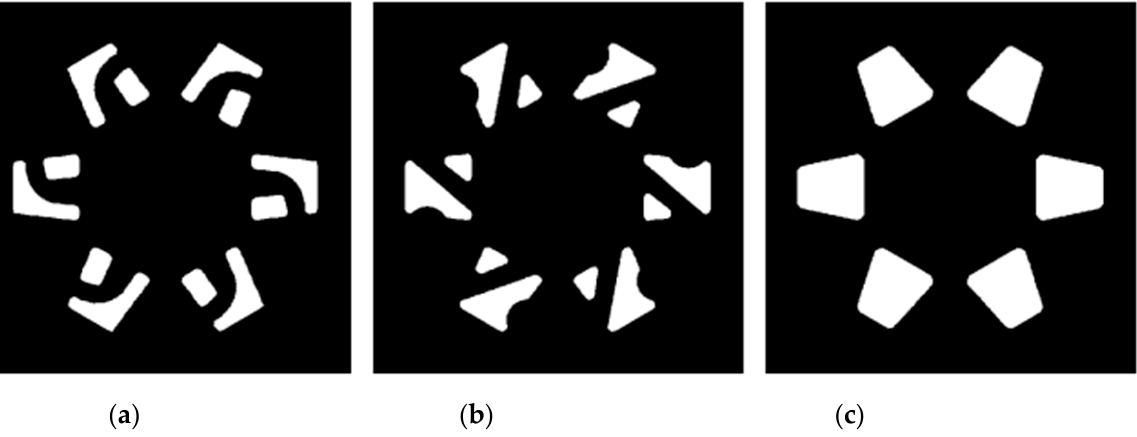
Figure 5. Simulated tool heads used in this work, containing six abrasive elements of: ( a ) 320 grit; ( b ) 400 grit; ( c ) 5 Extra grit.